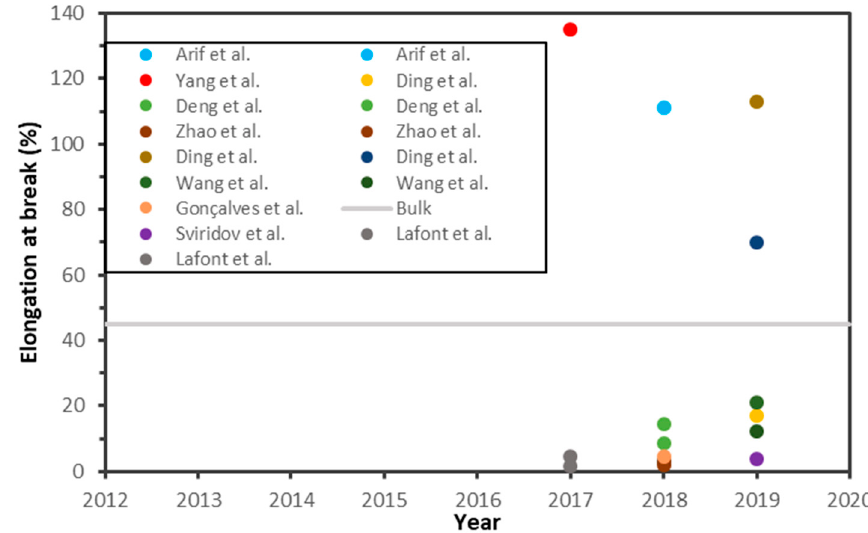
Figure 2. Tensile properties values for 3D-printed PEEK reported in the literature.